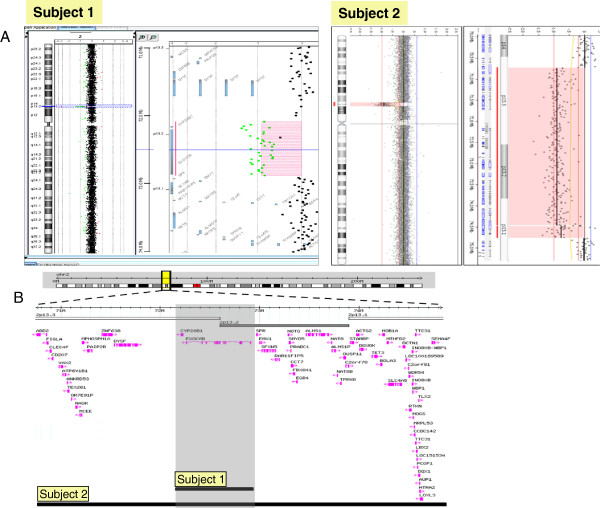
Array CGH result for Subject 1 and 2. A. Whole genome array profiles in Subject 1 and 2 showing microdeletions of 2p13; B. Gene content for the microdeletions in Subject 1 and 2.